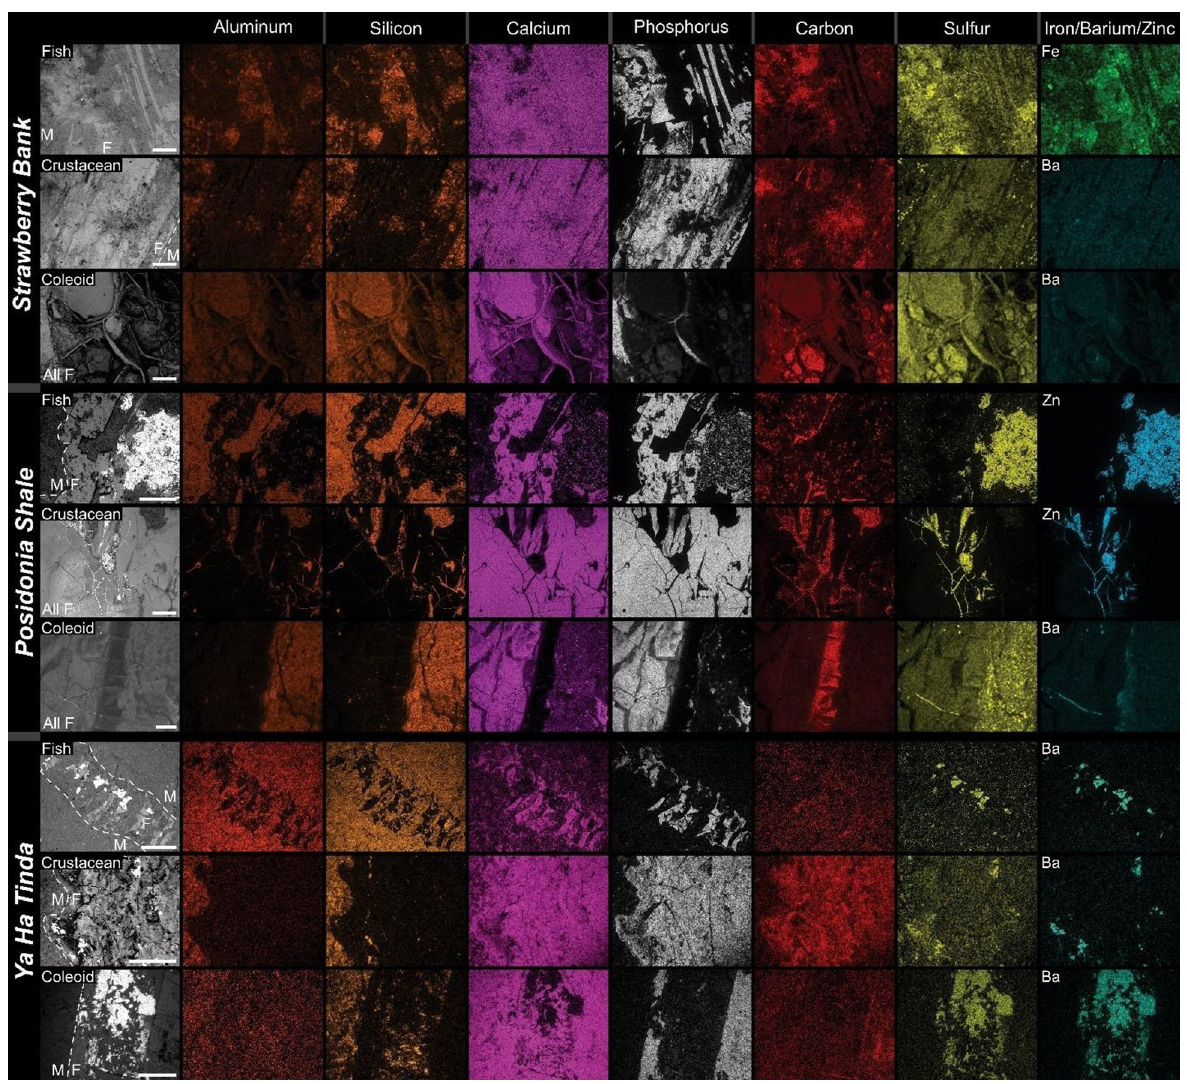
Figure 5. EDS elemental maps of specimens (areas from Fig. 4) from Strawberry Bank (SB), Posidonia Shale (PS), and Ya Ha Tinda (YHT) Lagerstätten fossils. Top to bottom- SB Fish, Phosphatized gut of Leptolepis (M1261; Fig. 4a). SB Crustacean, phosphatized exoskeleton of crustacean (M1256; Fig. 4g). SB Coleoid, phosphatized mantle and carbonaceous ink sac of vampyropod gladius (M3917; Fig. 4k) and alumino-silicate rich matrix. PS Fish, Phosphatized fish bone (NPL00036036.000; Fig. 4l). PS Crustacean, phosphatized Uncina posidoniae claw (NPL00036038.000; Fig. 4o). PS Coleoid, phosphatized mantle tissue of Loligosepia aalensis (NPL00036037.000; Fig. 4s) gladius with ink sac, surrounded by carbonaceous material. YHT Fish, Phosphatized skeletal material encrusted by barite (TMP2014.021.0043; Fig. 4v). YHT Crustacean, phosphatized claws of Uncina pacifica (TMP2018.024.0030; Fig. 4w) and carbonaceous material (encrusted by barite). YHT Coleoid, phosphatized gladius of Paraplesioteuthis cf. sagittate (TMP2005.028.0001; Fig. 4y), encrusted by calcite and barite . All scales = 1 mm. F = segments where fossil is present and M = segment where matrix is